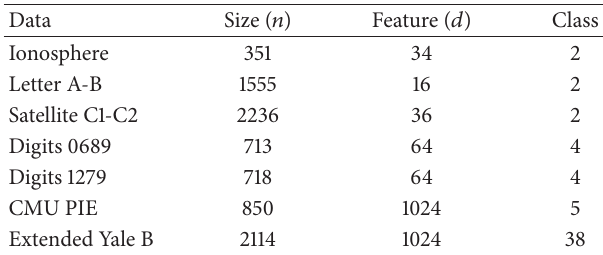
Table 1: Description of the